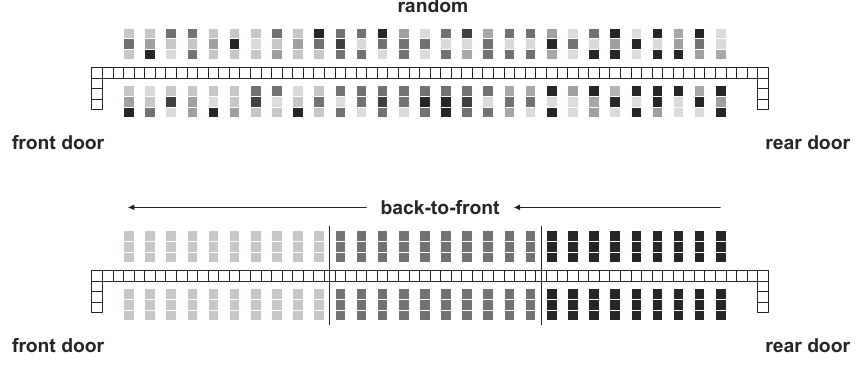
Figure 4. Example for random and back-to-front boarding strategy (darker seats are boarded first).